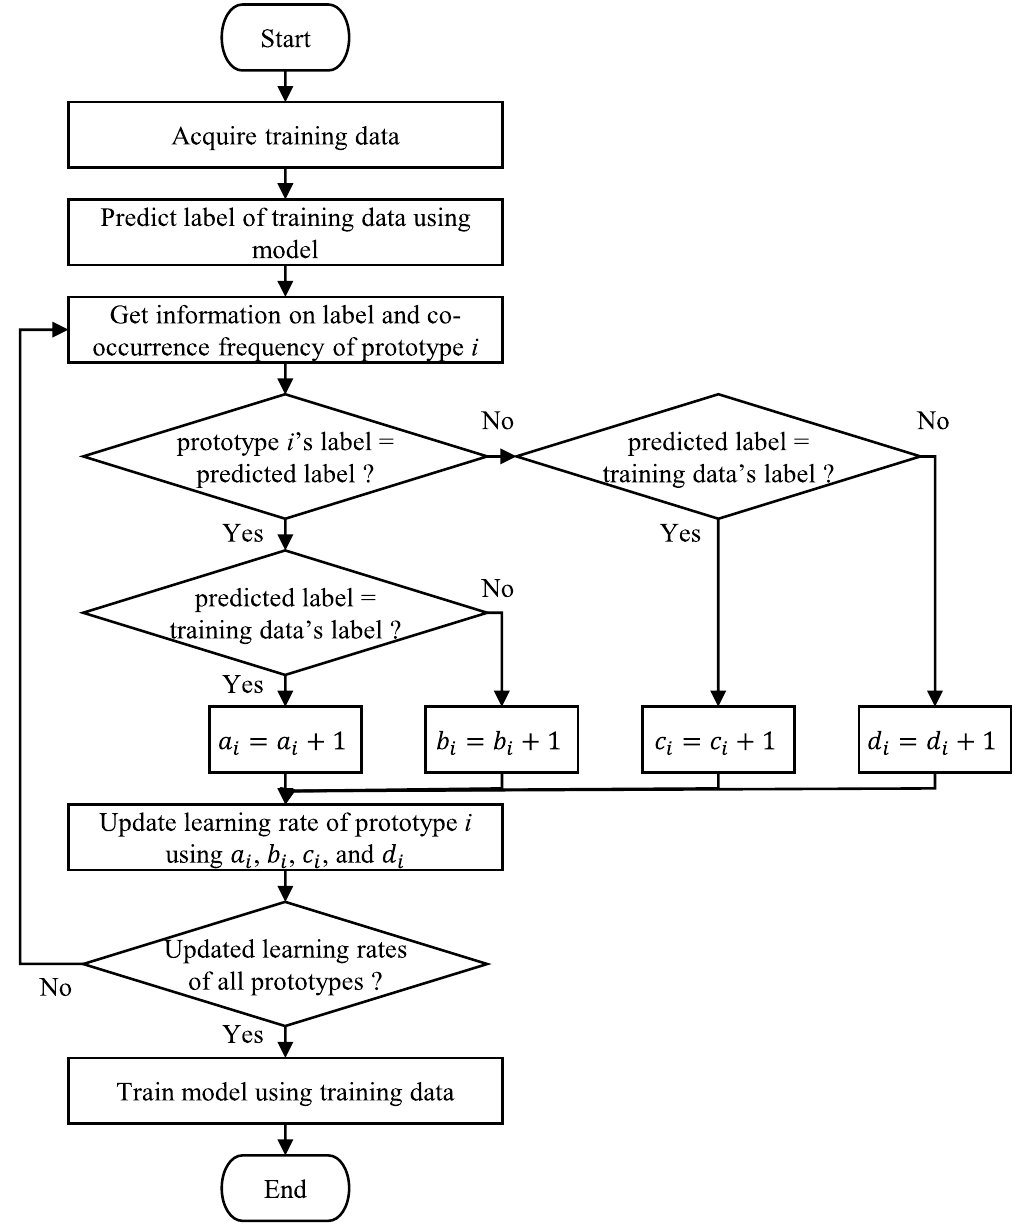
Figure 1. Flowchart of method for automatic adjustment of learning